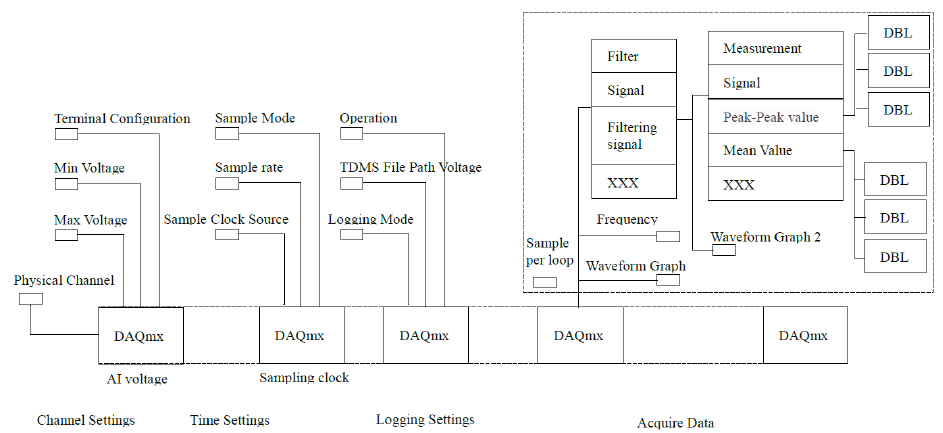
Figure 8. Process and work principle of data collection by LabVIEW.